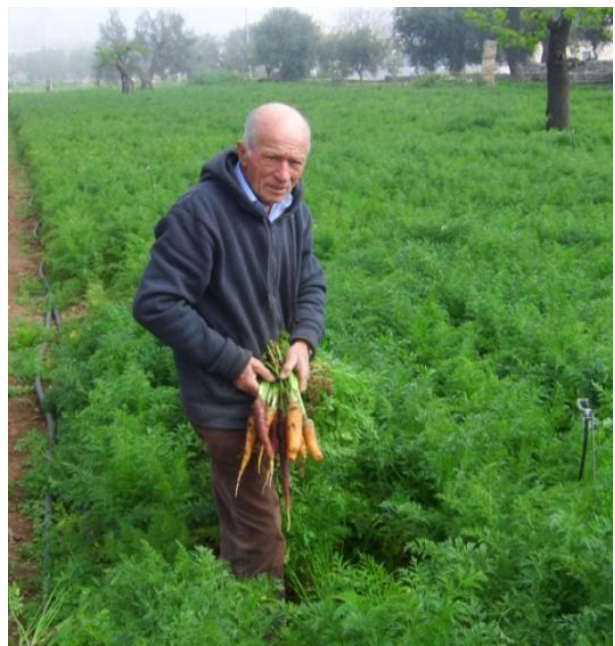
Figure 18. A local old seed savers (Oronzo Giuliacci) of the Polignano carrot.